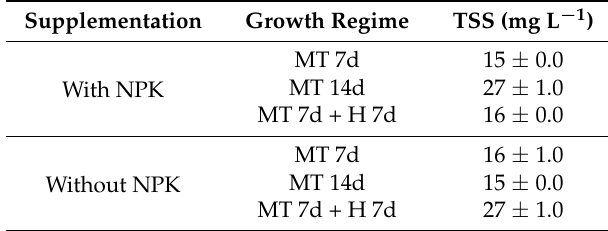
Table 2. Total suspended solids (TSS) concentration (mg L − 1 ) of controls, that is, a birch hydrolysate and dairy effluent medium without microalgae inoculation, with and without NPK supplementation, cultivated for 7 and 14 days mixotrophically (MT 7d and MT 14d, respectively), or for 7 days mixotrophically and then another 7 days heterotrophically (MT 7d + H 7d). Values are expressed as mean ± standard deviation ( n =